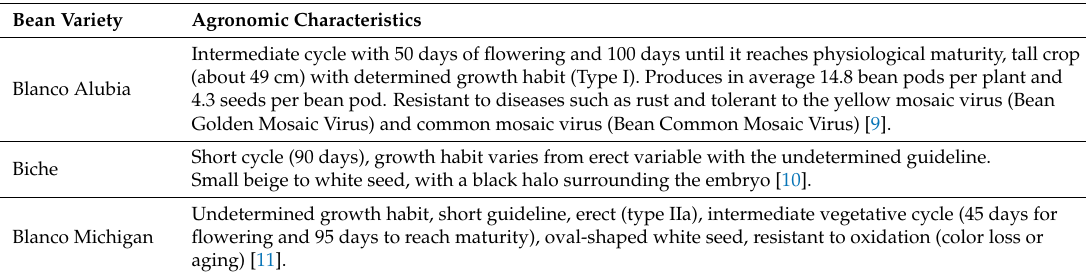
Table 2. Agronomic characteristics of evaluated bean varieties.